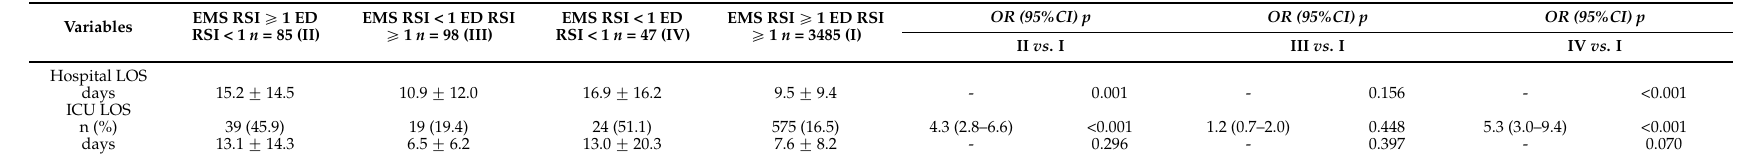
Table 4. Length of stay in the hospital and the intensive care